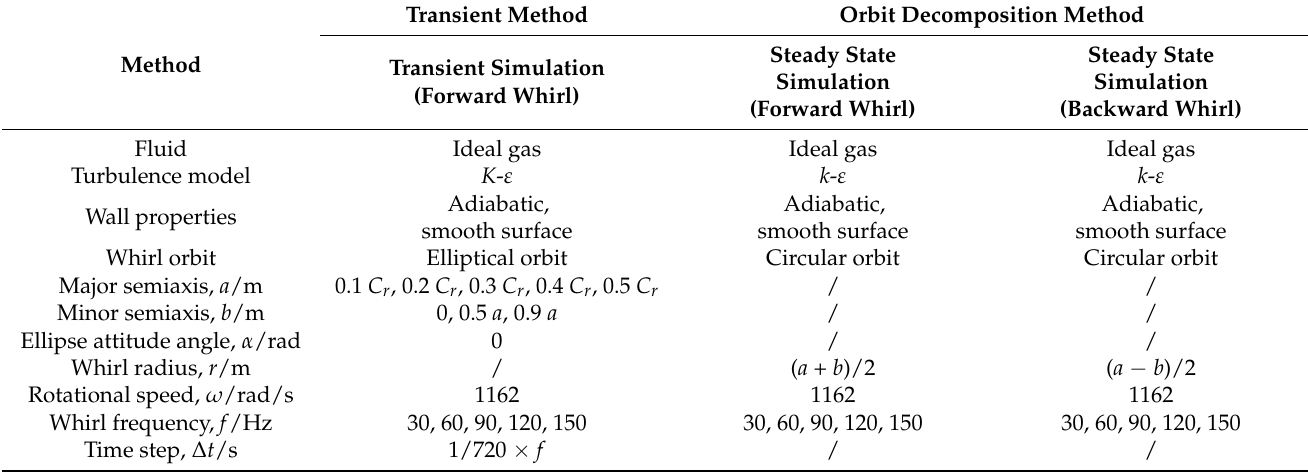
Table 2. Calculating